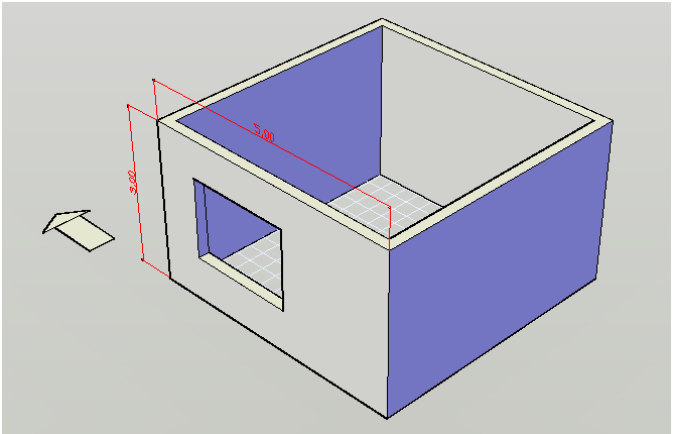
Figure 7. Sketch of the heated space.